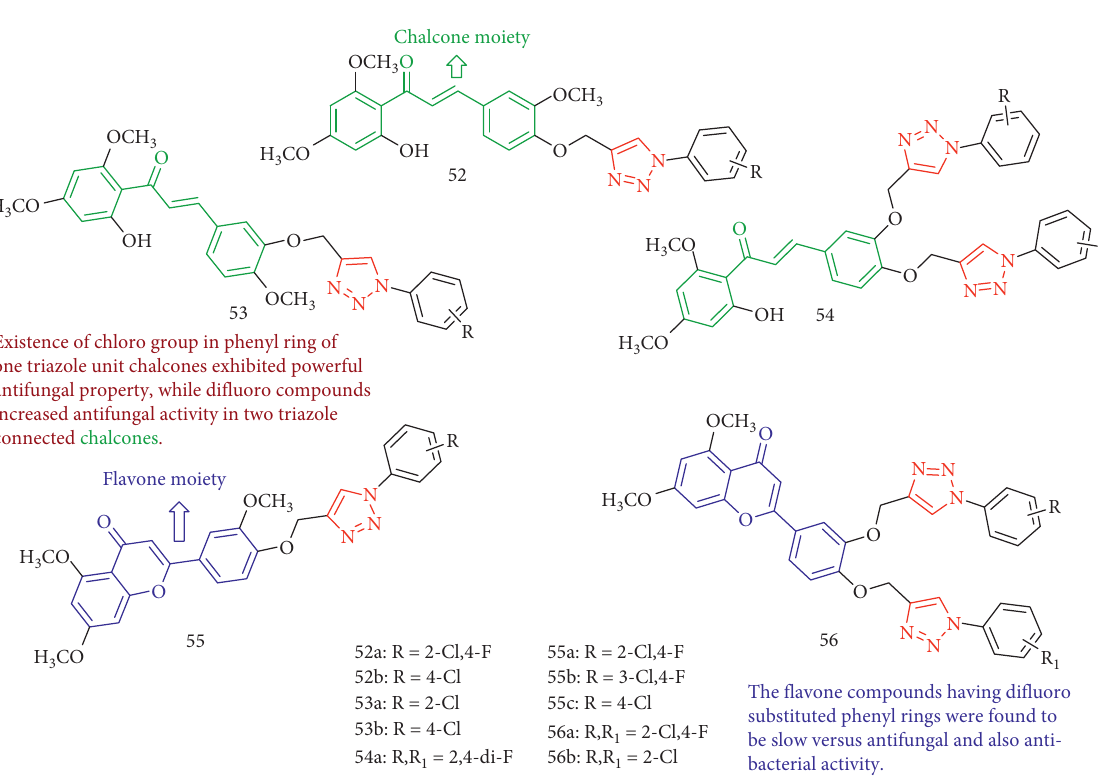
Figure 12: Chemical structure of newer 1,2,3-triazole-linked chalcone and flavone hybrid